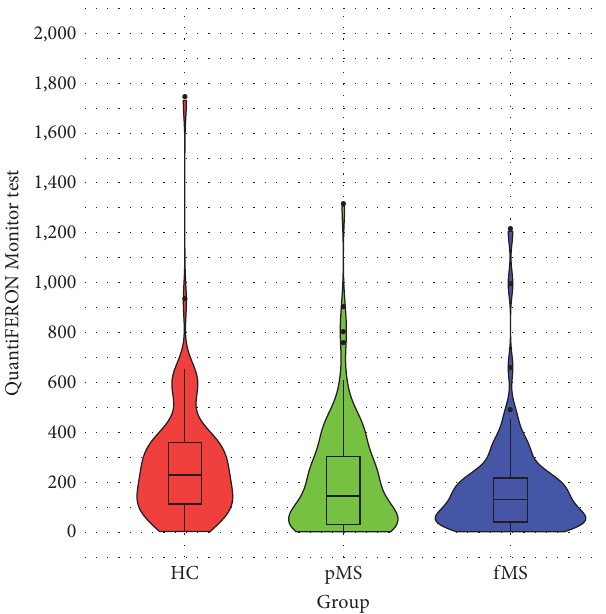
F IGURE 1: Distribution of measured values of the QFM for each group. Note: the violin plot shows the distribution (probability density) of the QFM scores. Inside the plot, there is a box plot showing the upper and lower quartiles (upper and lower sides of the rectangle) and the median value (bold line inside the diagram). HC, healthy controls; pMS, progressive MS patients; fMS, MS patients treated with fi ngolimod.